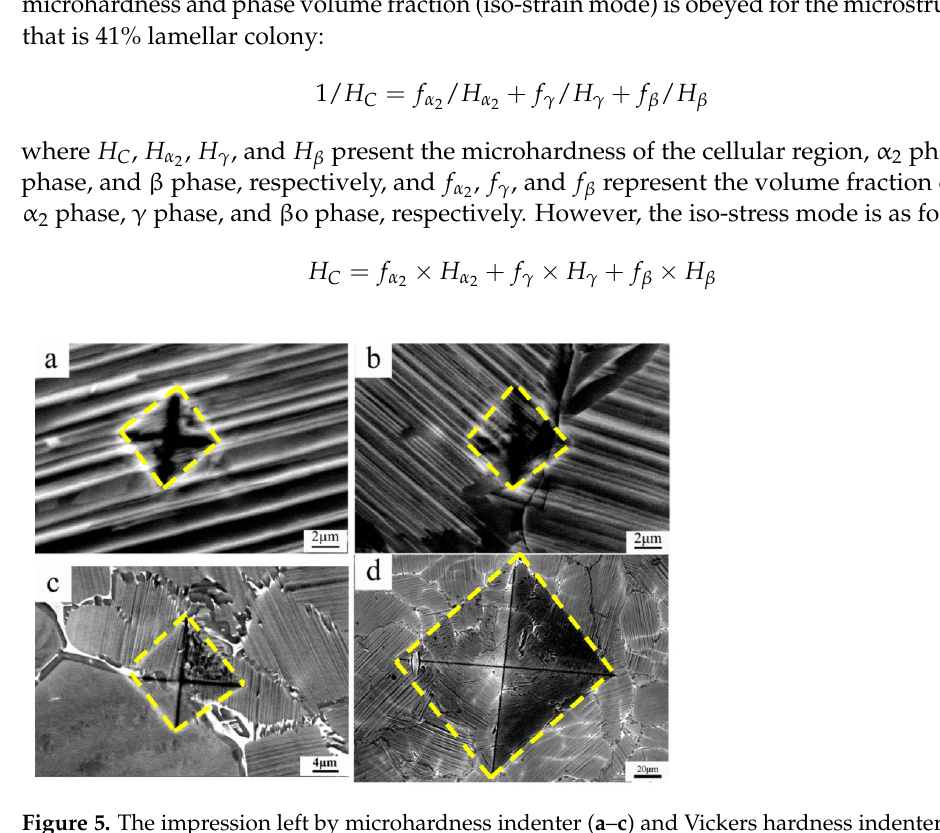
Figure 6. The relationship between lamellar spacing and Vickers hardness. 4. Conclusions The alloys with four different compositions were designed for studying the effect of Al and Mo content on the microstructure and properties of TNM TiAl alloys. The follow- ing conclusions have been drawn: (1) After a decrease of 0.5 at.% Mo and/or increase of 1.5 at.% Al in the typical TNM alloy, the alloys have an NL microstructure with a few β o phases at the colony boundaries or in the lamellar colony. The lamellar colony size and the lamellar spacing have in- creased with the decrease in Mo and the increase in Al. The volume fraction of the β o phase decreases with the decrease in Mo and the increase in Al, and that of α 2 de- creases with the increase in both Al and Mo contents. Mo is rich in the β o phase, and the reduction in its content reduces the content of each phase in proportion. The in- crease in Al content in the alloy leads to the corresponding increase in Al content in the α 2 and γ phases. The increased content of Al and decreased content of Mo is